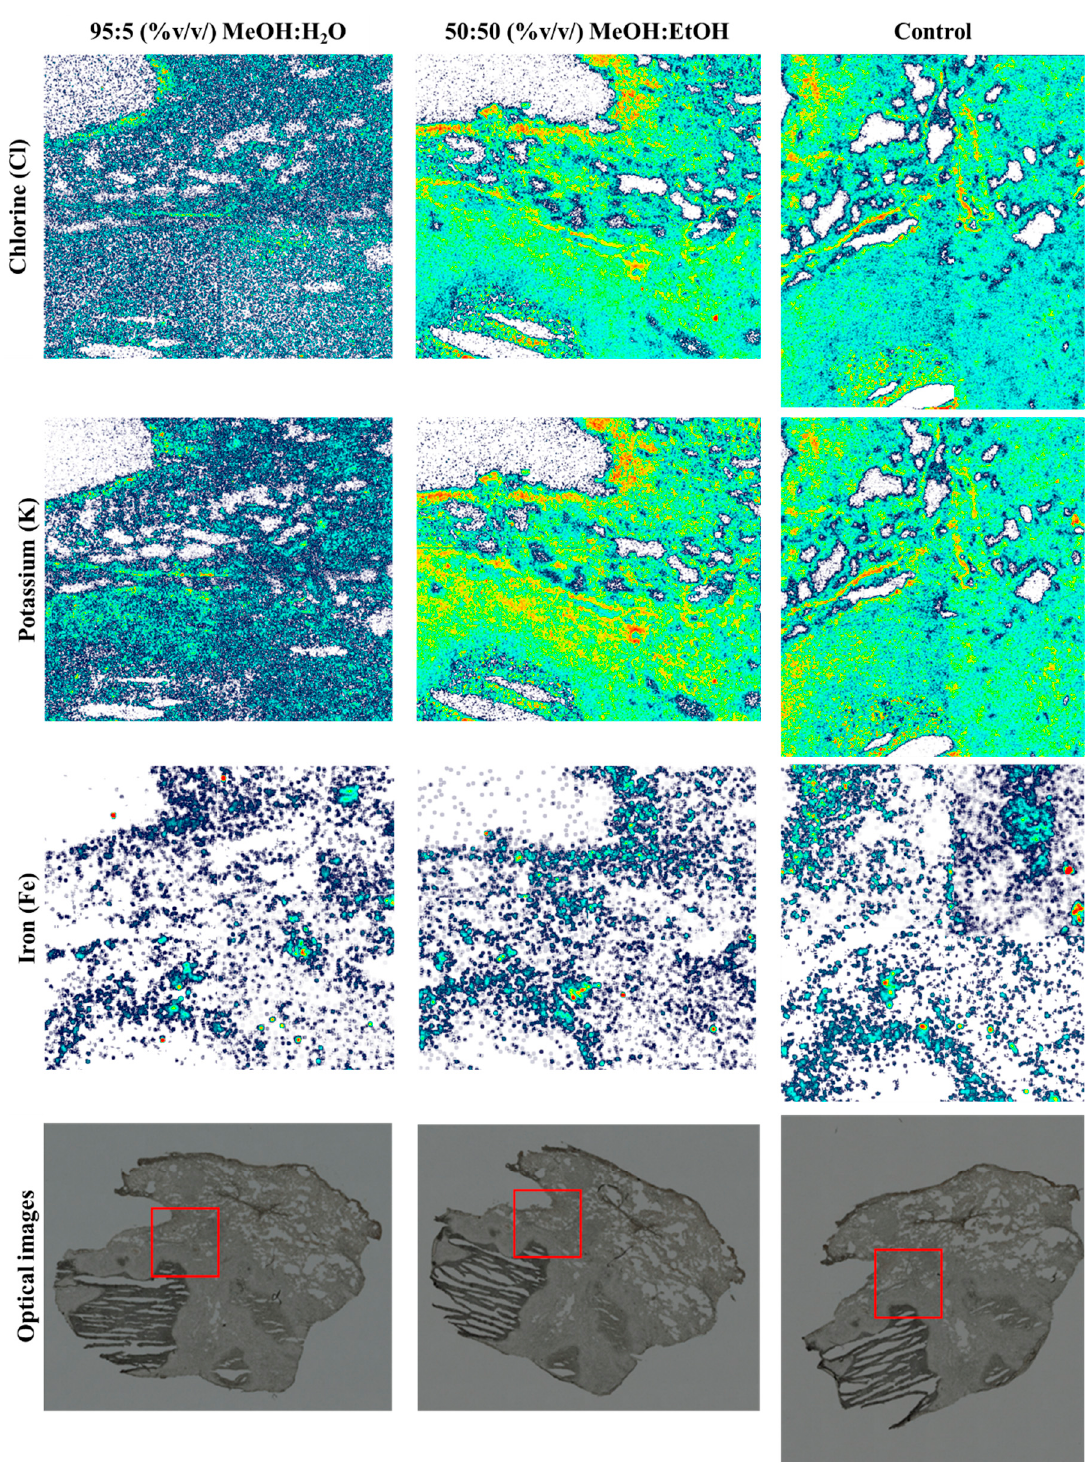
Figure 5. Chlorine (Cl), potassium (K) and iron (Fe) PIXE maps taken from snap-frozen lung tissue sections after DESI analysis using 95:5 (% v/v ) MeOH:H 2 O or 50:50 (% v/v ) MeOH:EtOH. A third section (control) was also analysed—no DESI measurements were taken on this sample. Optical images taken before analysis highlighting the PIXE/EBS analysis areas (red squares) on each tissue.